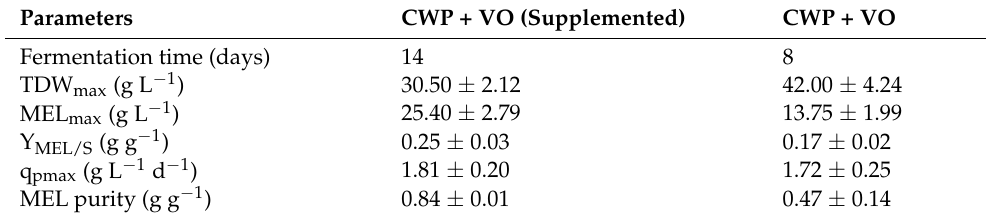
Table 1. Maximum concentrations of TDW and MEL production (g L − 1 ); yield of produced MEL (g MEL/ g Substrate ), maximum productivity (g L − 1 d − 1 ), and purity (g g − 1 ) of M. antarcticus PYCC 5048 T using CW and VO (20 g L − 1 ) in the presence or absence of mineral medium with YE and NaNO 3 . Parameters CWP + VO (Supplemented) CWP + VO Fermentation time (days)